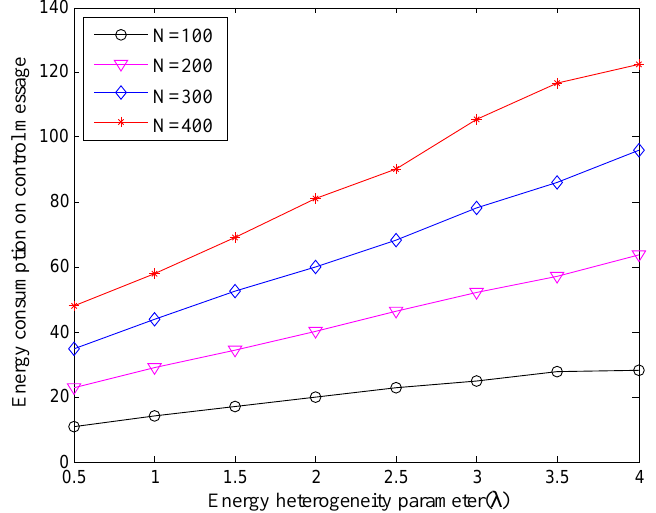
Figure 6. The total energy consumption (J) for control message of the whole network under different energy heterogeneity